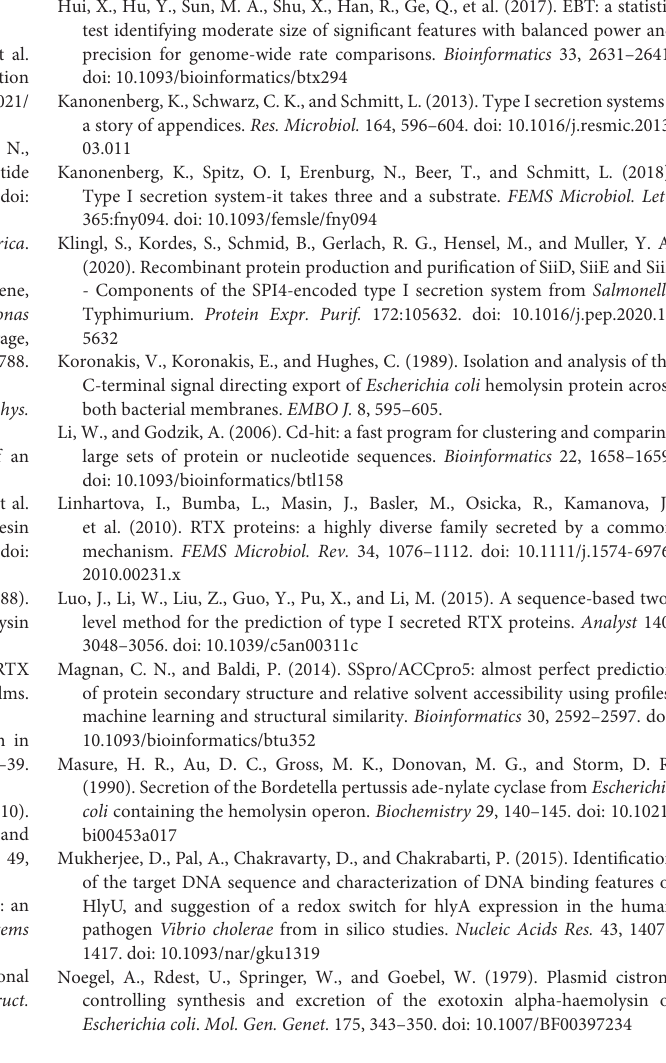
Supplementary Figure 1 | Position-specific Aac profile difference between the C termini of repeats-in-toxin (RTX) proteins and three independent groups of non-RTX proteins. Supplementary Figure 2 | Position-specific Aac profile difference between the N termini of RTX proteins and three independent groups of non-RTX proteins. Supplementary Figure 3 | ROC curves of T1SEstacker and pT1SEstacker models on the verified T1SEs and non-T1SEs. (A) Performance of T1SEstacker_C60 and pT1SEstacker_C60 on 99 verified T1SEs and 512 non-T1SEs. (B) Performance of T1SEstacker_C20 and pT1SEstacker_C20 on 99 verified T1SEs and paired 99 non-T1SEs. (C) Performance of T1SEstacker_C20 and pT1SEstacker_C20 on 99 verified T1SEs and 512 non-T1SEs. The best-optimized cutoff for the decision of T1SEstacker models are indicated with red arrows. Supplementary Dataset 1 | Sequential Aac comparison between the C termini of repeats-in-toxin (RTX) and non-RTX proteins. Supplementary Dataset 2 | Repeats-in-toxin motif distribution within the experimentally verified T1SEs and the prediction results of T1SEstacker_C60 and T1SEstacker_C20. Supplementary Dataset 3 | Salmonella T1SEs predicted with